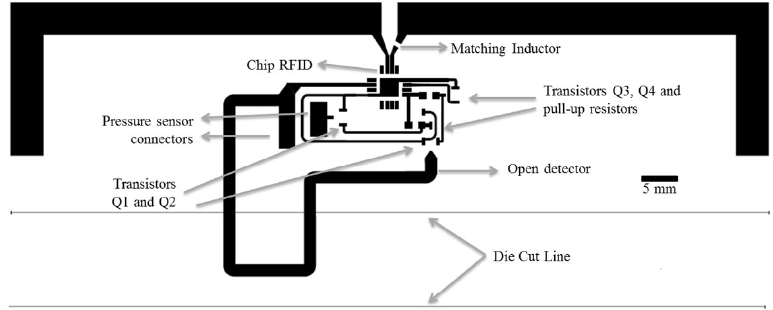
Figure 25. Layout of a chip–based digitally integrated force sensor